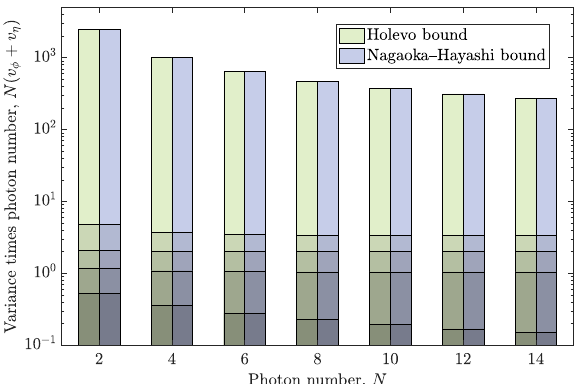
Fig. 4 The Holevo and Nagaoka – Hayashi bounds multiplied by photon number for estimating phase change ϕ and transmissivity η using the Holland – Burnett states. The numerical results show that the two bounds coincide for N up to and including 14 for any value of η . We show in the main text that there exists a separable measurement that reaches the ultimate attainable precisions in this example. In this case, a collective POVM cannot perform better than a separable POVM. Different shades correspond to different η values, with darker colours corresponding to larger η . Results are shown for η = 0.01, 0.25, 0.5, 0.75, and 0.99.